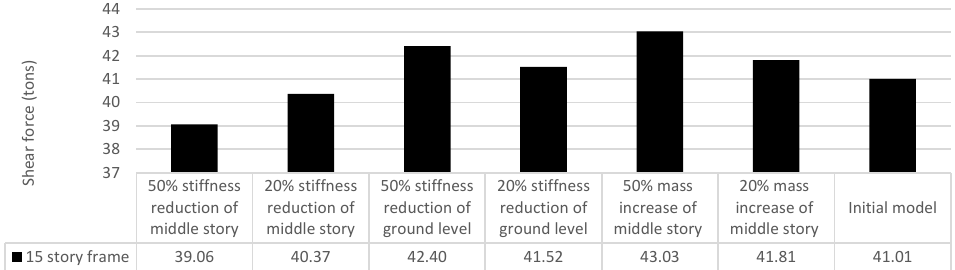
Fig. 5. Shear force results of 15 story